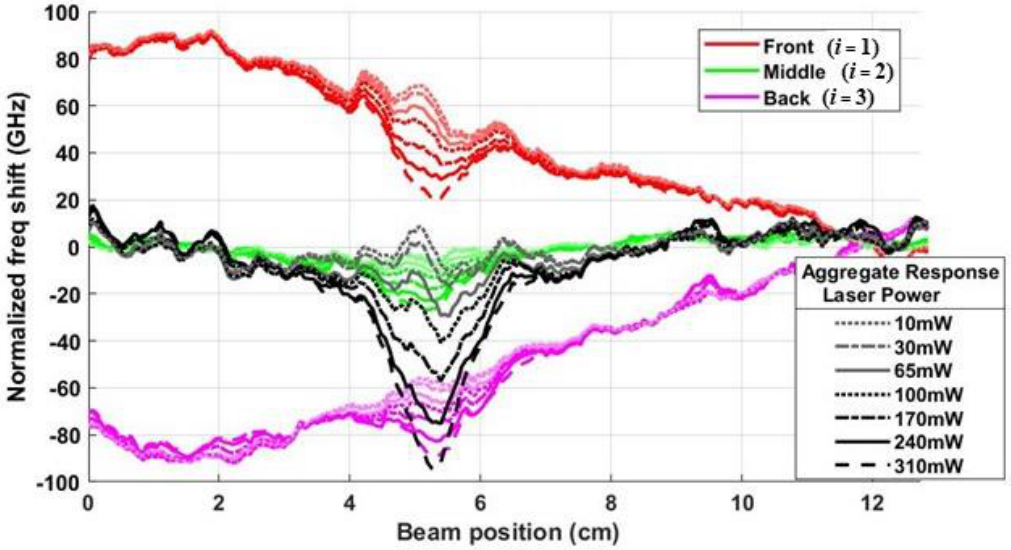
Figure 12. Plots of the normalized responses from Equation (9), corresponding to the combined strain and temperature response in Equation (10), as measured in the front, middle and back Segments of the DOFS ( i = 1 − 3 ) . The aggregate response (in black) is the combination of the scaled responses, as defined in Equation (9), for each optical power setting.